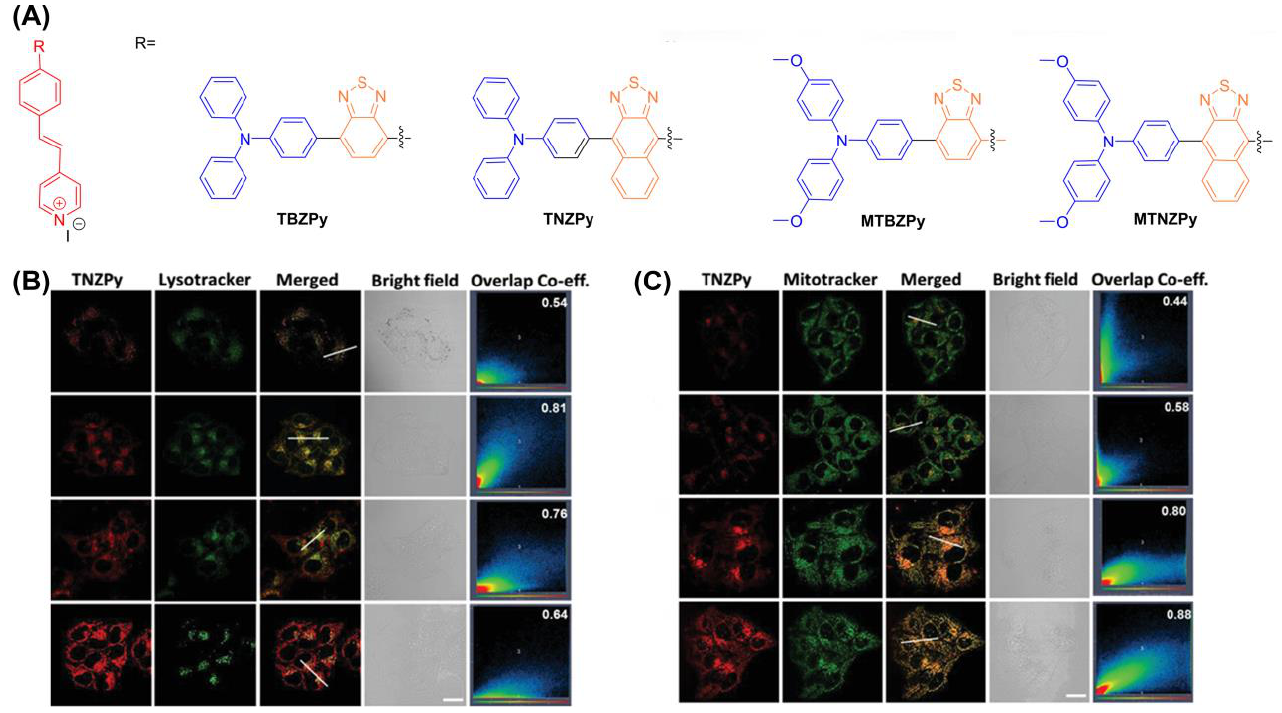
Figure 21. ( A ) Chemical structure of TBZPy, MTBZPy, TNZPy, MTNZPy; ( B ) CLSM images of HeLa cells stained with TNZPy and Lysotracker green; ( C ) CLSM images of HeLa cells stained with TNZPy and Mitotracker green. Reprinted with permission from Ref. [138]. Copyright 2020 WILEY-VCH. In 2020, Tang et al. proposed a pioneering strategy of 1 + 1 + 1 > 3 (Figure 22) [41].